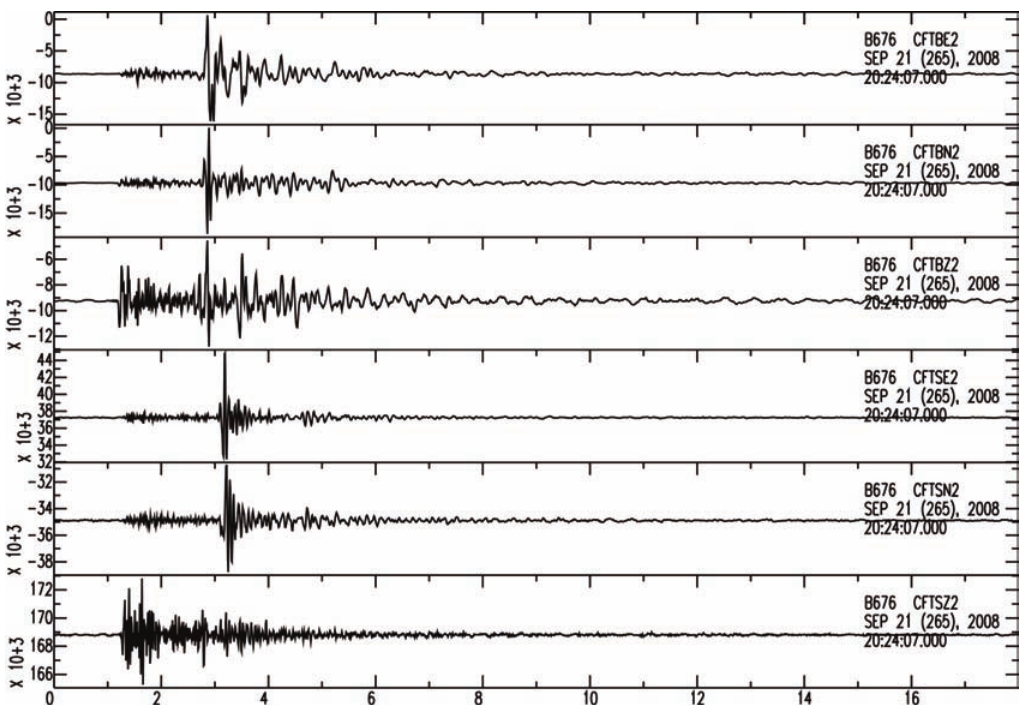
Figure 3. First records of the borehole station CFTB (borehole) and CFTS (surface). The earthquake occurred on September 21, 2008, at